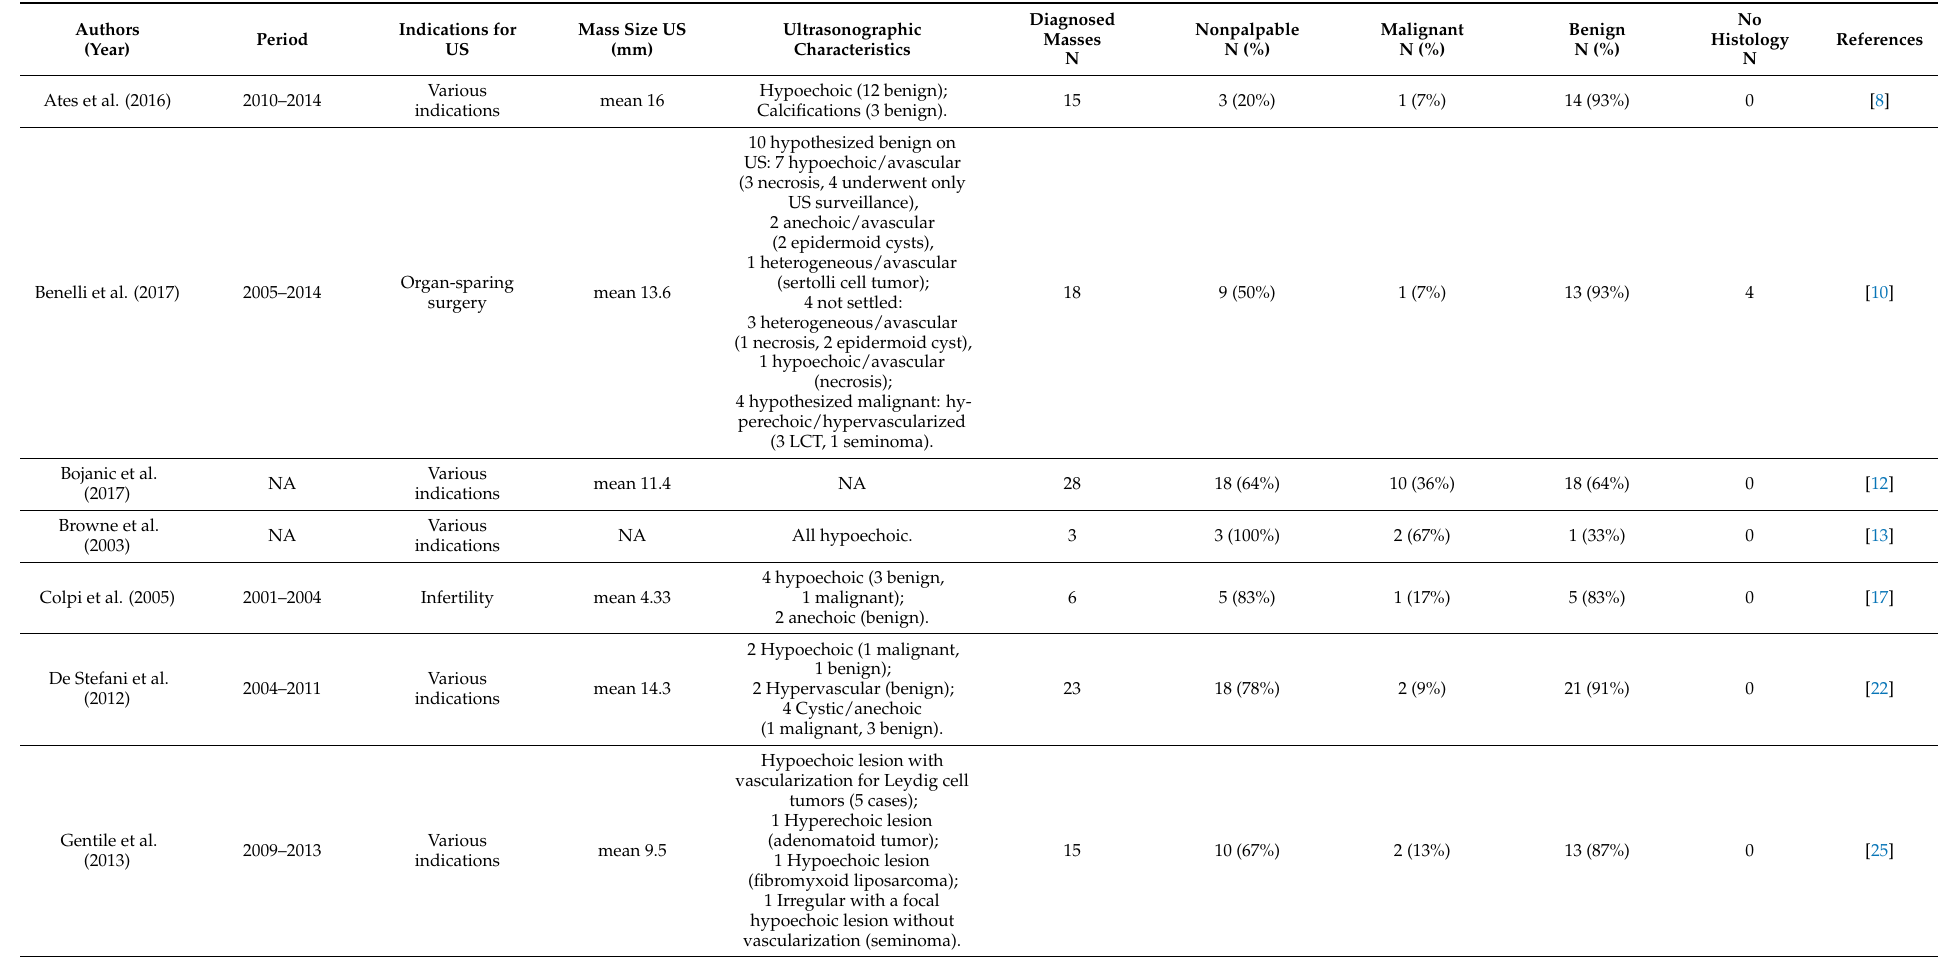
Table 2. Prevalence of nonpalpable testicular masses in surgical case